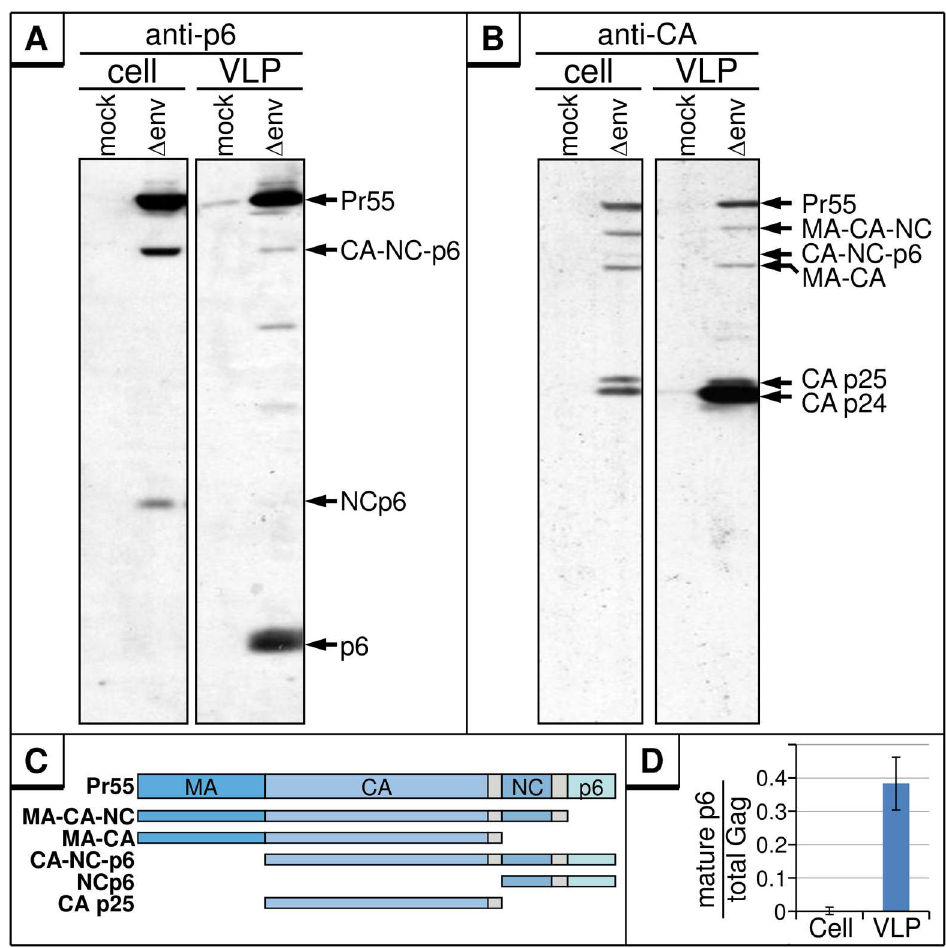
Western blottingusinga p6-reactive( A )or a CA-reactive ( B )antiserum. ( C )Schematic depiction of Gag processing products observablein A and B. ( D )Quantitative analysisof mature p6 versus total amountof p6-containingGag proteinsfor cell and VLP fractions. Valuesrepresentthe arithmeticmean of 3 independently performed experiments ±